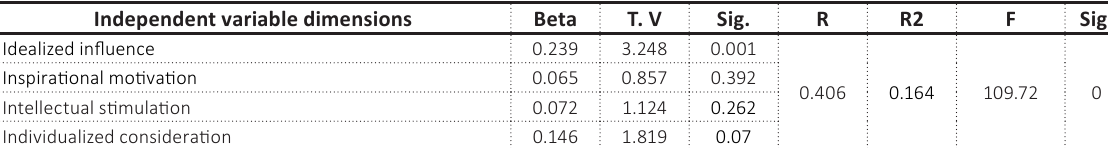
Table 11. Regression analysis for the transformational leadership dimensions and